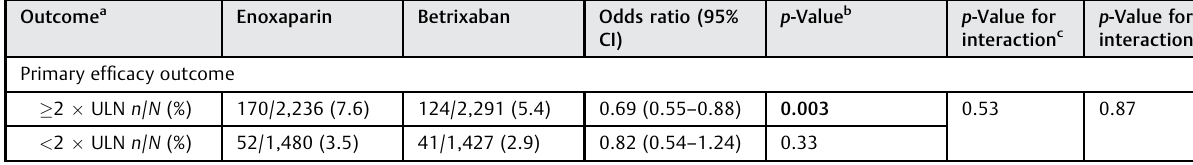
Table 3 Interaction of D-dimer category or D-dimer concentration and treatment effect through visit 3 Outcome a